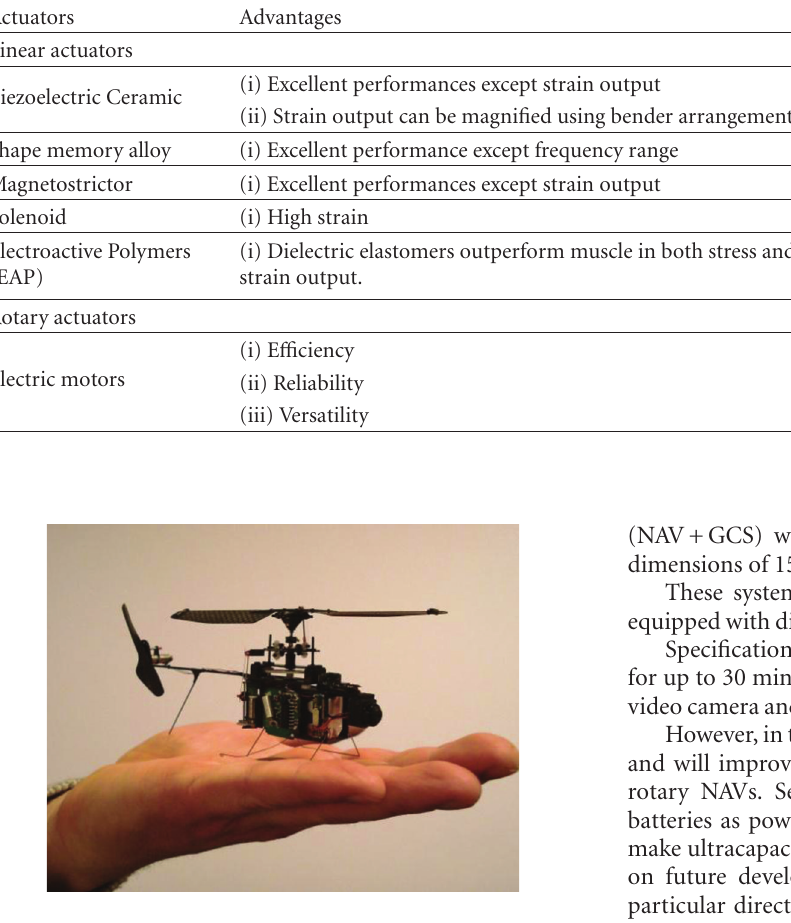
Figure 26: The Hornet 2-b (Prox Dynamics), complete with camera and video transmitter